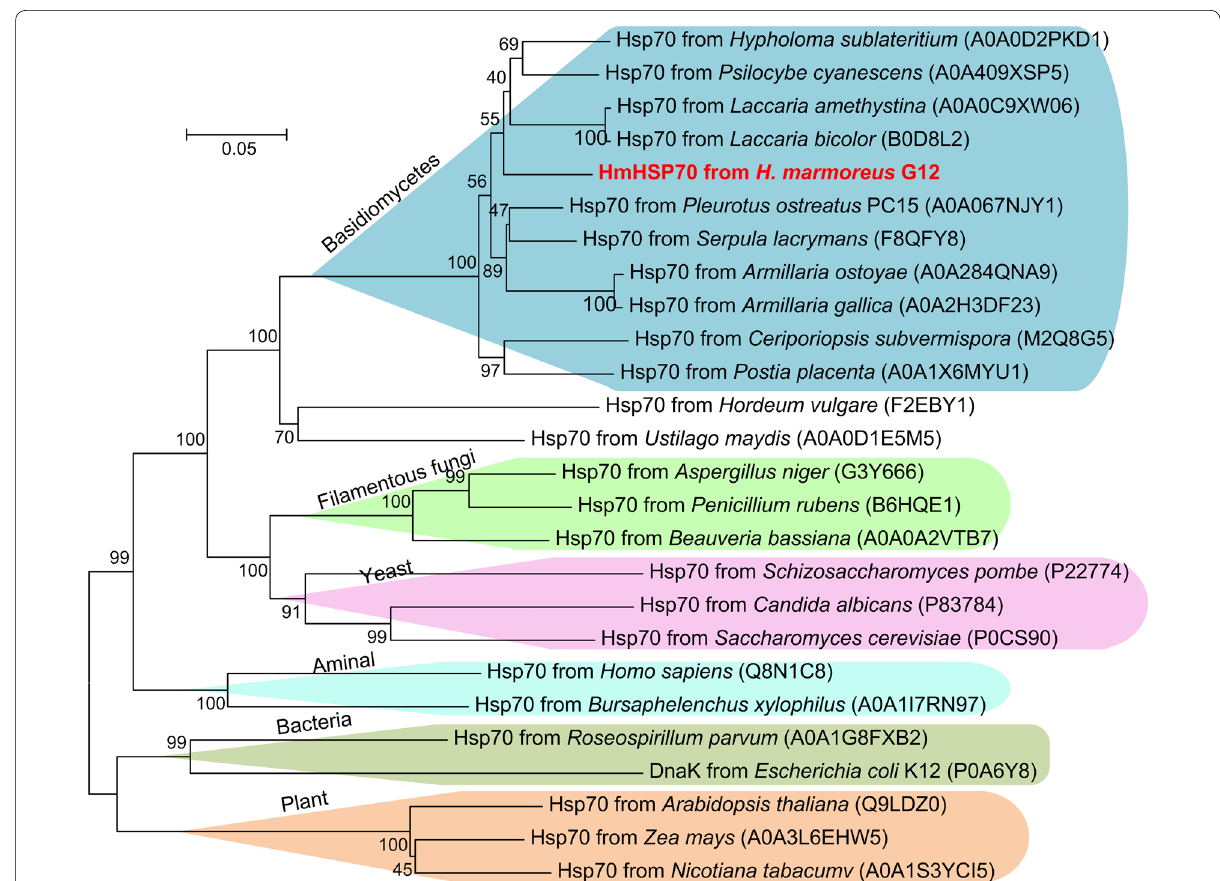
Fig. 2 A neighbor-joining phylogenetic tree of HmHsp70 and relative Hsp70 proteins made by MEGA 6.0 software. GenBank accession numbers are indicated in parentheses. Numbers next to nodes indicate bootstrap values from 1000 replicates. Bar indicates evolutionary distance of 0.05 per 1000 amino acid